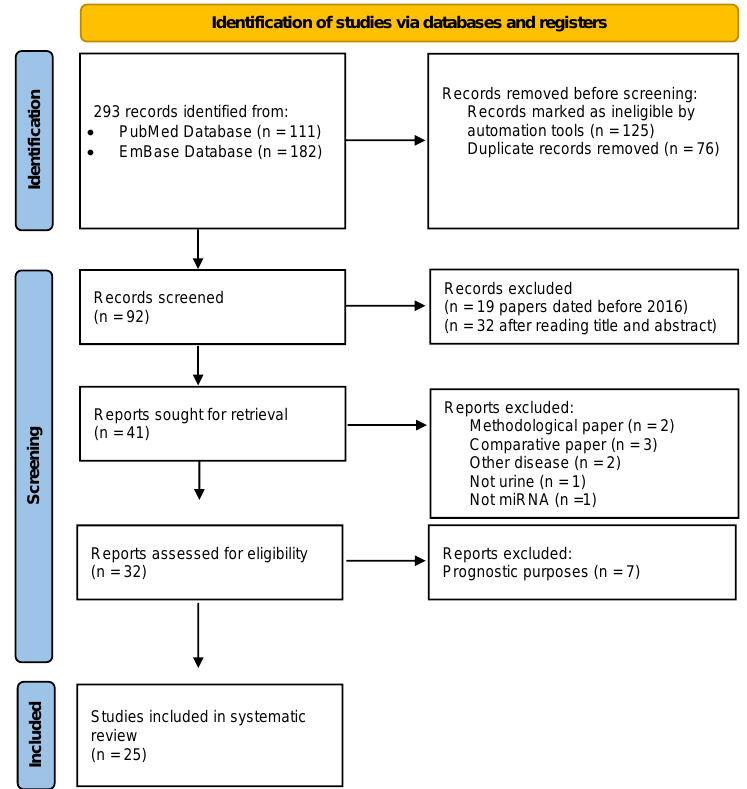
Figure 1. PRISMA 2020 flow diagram, which included searches of the databases.